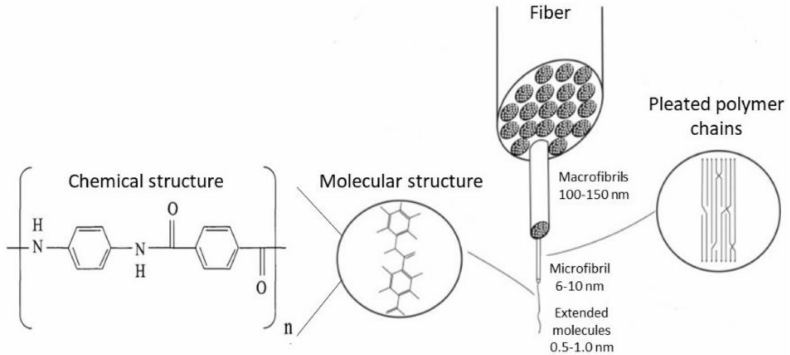
Figure 1. Chemical and fibrillar structure of para-aramid fiber, adapted from [24]. Reprinted with permission from ref. [24]. Copyright 2008